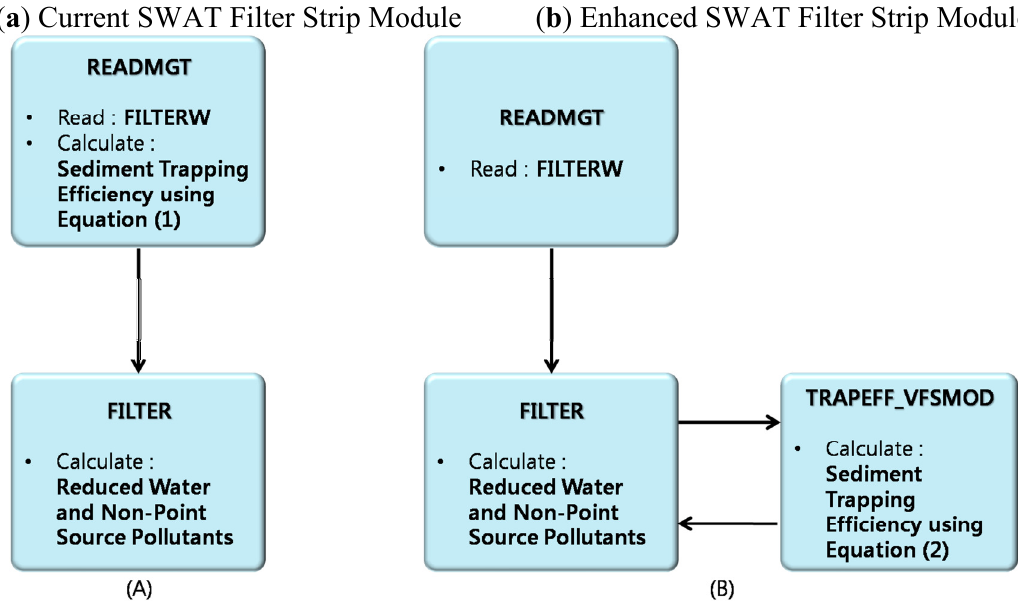
Figure 7. Enhancement of the SWAT Filter Strip